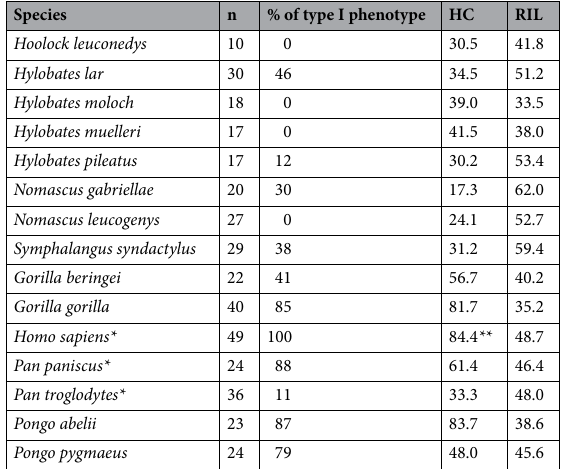
Table 1. Summary of data on ape ocular pigmentation patterns. Type I phenotype describes eyes in which the sclera is lighter than the iris. HC and RIL correspond to species means. *Data derive from Perea García et al. 8 . **n =